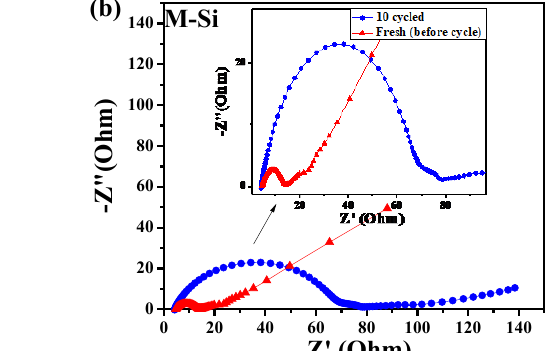
Figure 9. Charge/discharge curves of ( a ) B-Si and ( c ) M-Si electrodes at 20th, 30th, 40th, 50th, 60th, and 70th cycles. Rate capability tests of ( b ) B-Si and ( d ) M-Si electrodes under different current densities of 0.2C, 0.5C, 1C, 2C, 3C, 5C, and 0.2C.